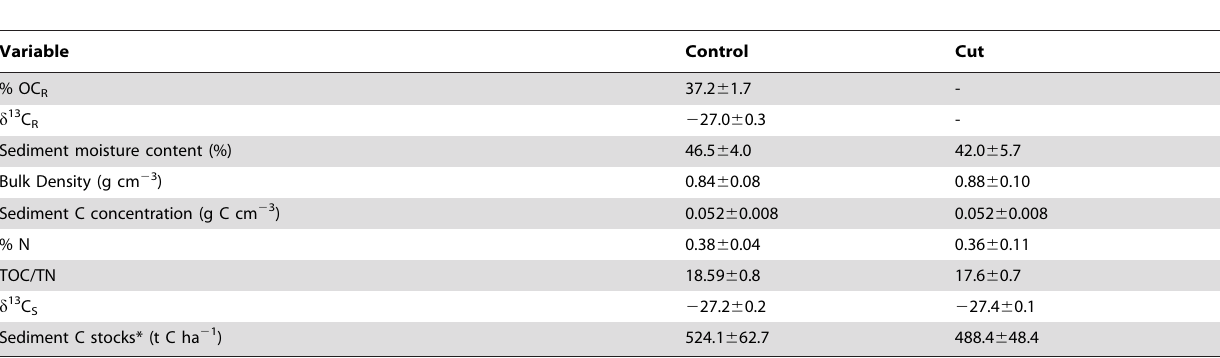
Table 2. Belowground roots and sediment biochemical characteristics in control and cut plots in R . mucronata forest at Gazi bay,